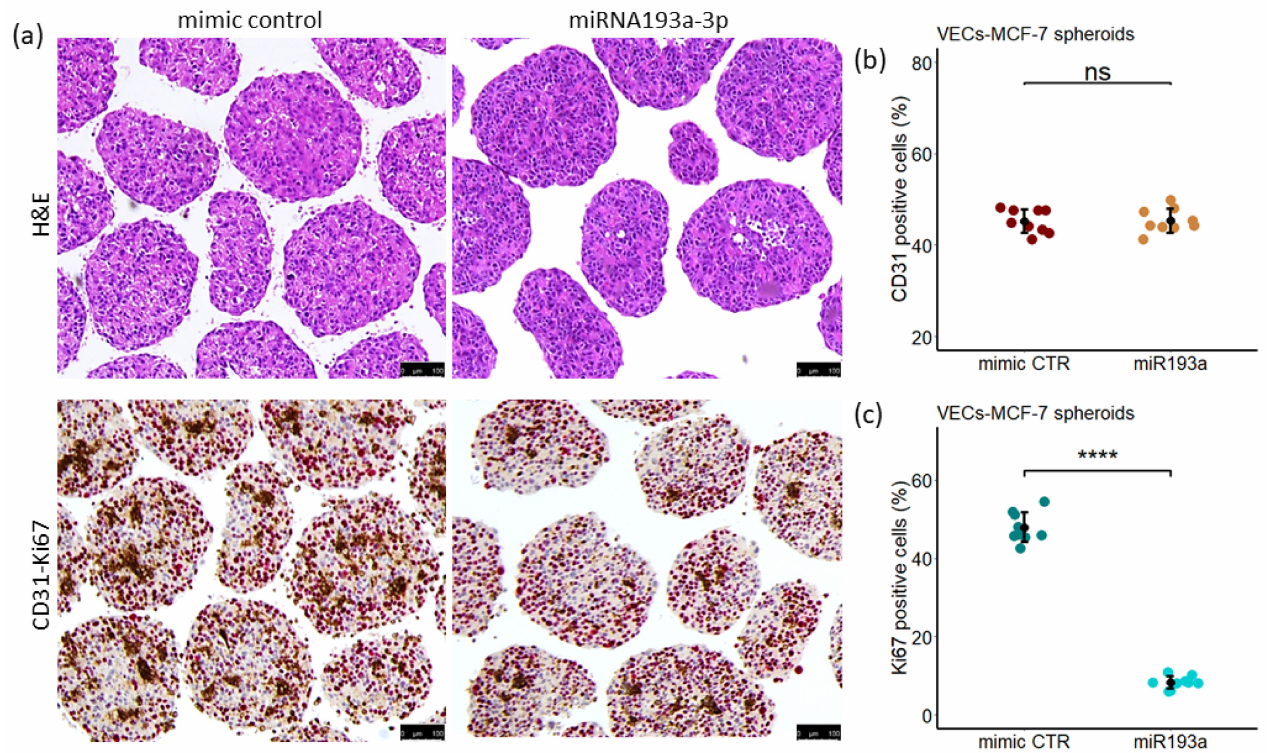
Figure 13. Immuno-histochemical staining of spheroids transfected with mimic control and miR193a-3p. ( a ) Upper panels depict MCF-7+VEC transfected spheroid sections stained for H&E to highlight spheroid structure. Lower panels depict double IHC staining and bright field images of mimic control and miR193a transfected spheroids stained with CD31 an endothelial cell marker (red) and Ki67 as proliferative marker (brown). This image shows the distribution of VECs (stained) and MCF-7 (unstained) cells in the spheroid, as well as the proliferation activity in mimic control and miR193a treated spheroids. CD31 ( b ) and Ki67 ( c ) positive cells were calculated in MCF-7+VEC spheroids transfected with miRNA using ImageJ software. p < 0.0005 ****. ns = not significant. The percentages were calculated compared to the total number of cells within the spheroids. Scale bar, 100 µ m. Images from at least 10 spheroids were compared for qualitative and semi-quantitative